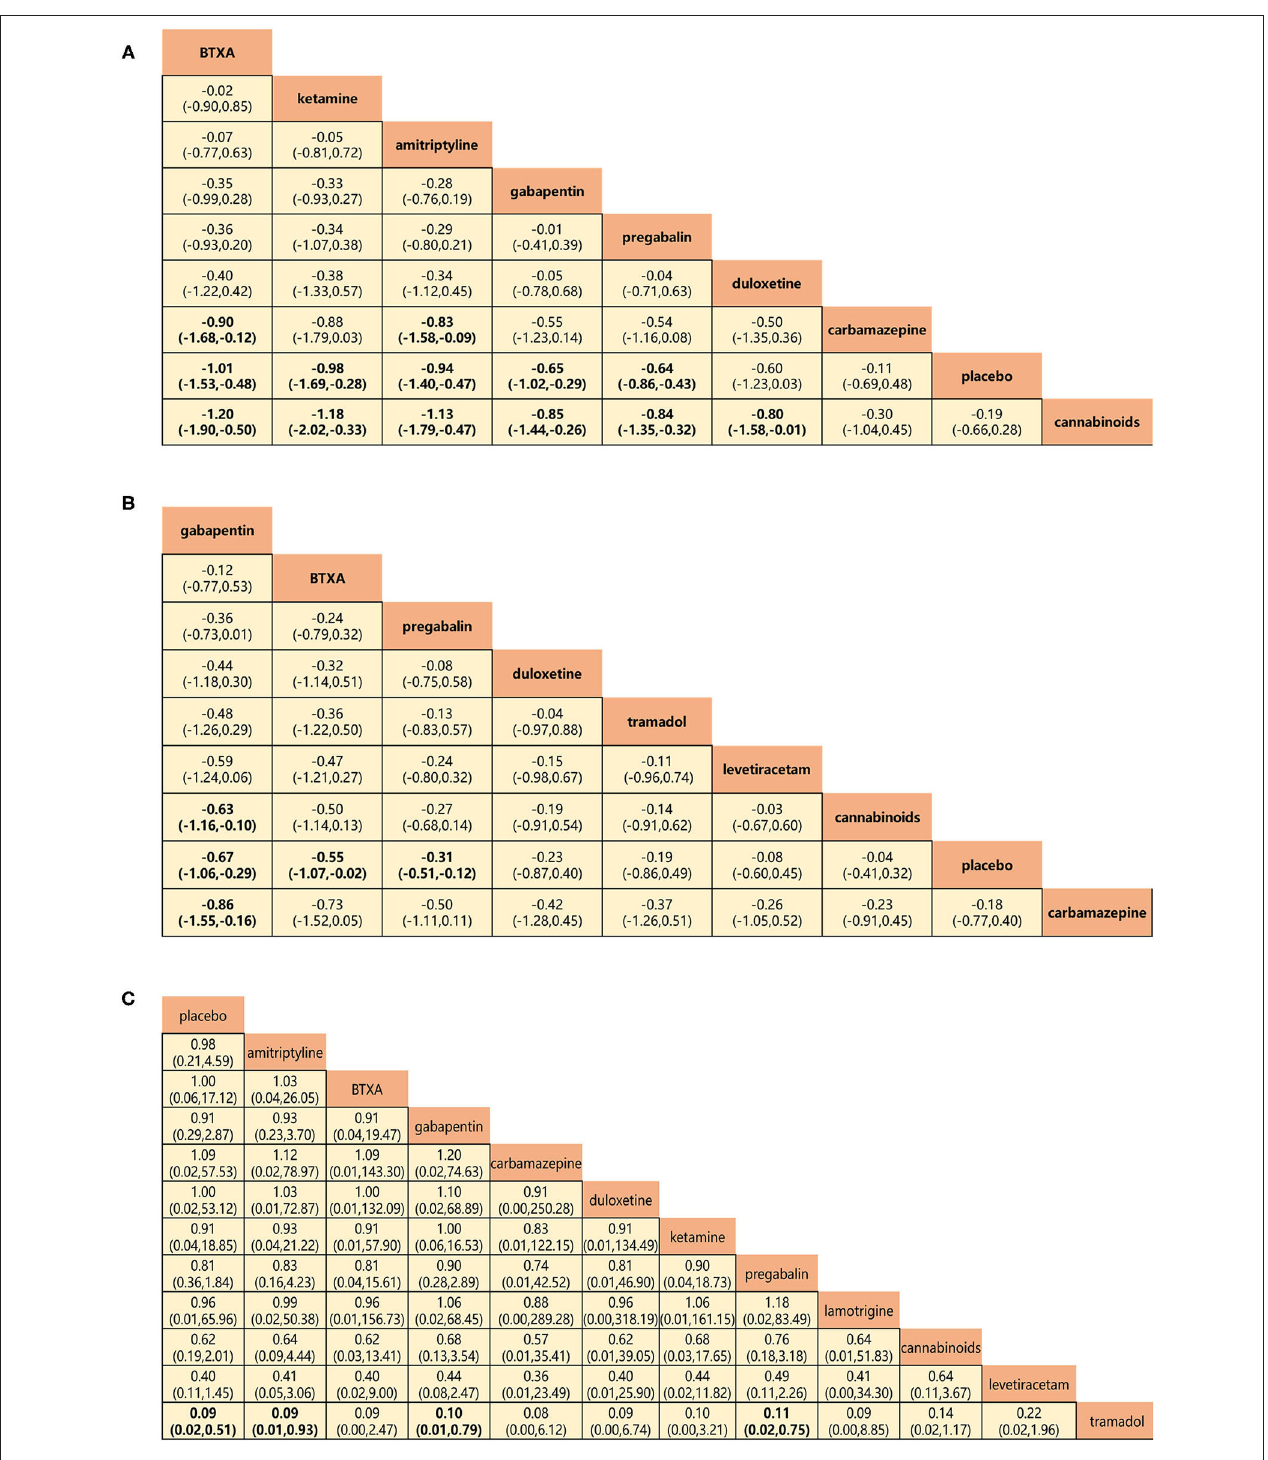
FIGURE 6 | Head-to-head comparisons for secondary outcomes of drugs and placebo. (A) Pain relief more than 8 weeks (8 drugs). (B) Mental or sleep-related symptom relief (8 drugs). (C) Serious adverse events (11 drugs). Drugs are reported in efficacy and safety order sorted from top left to bottom right. Data are SMDs (95% CrI) and ORs (95% CrI) in the column-defining treatment compared with the row-defining treatment. For A and B, SMDs lower than 0 favor the column-defining treatment. For C, ORs lower than 1 favor near the top left one. Significant results are in bold. SMD, standard mean deviation; OR, odds ratio; CrI, credible interval; BTXA, botulinum